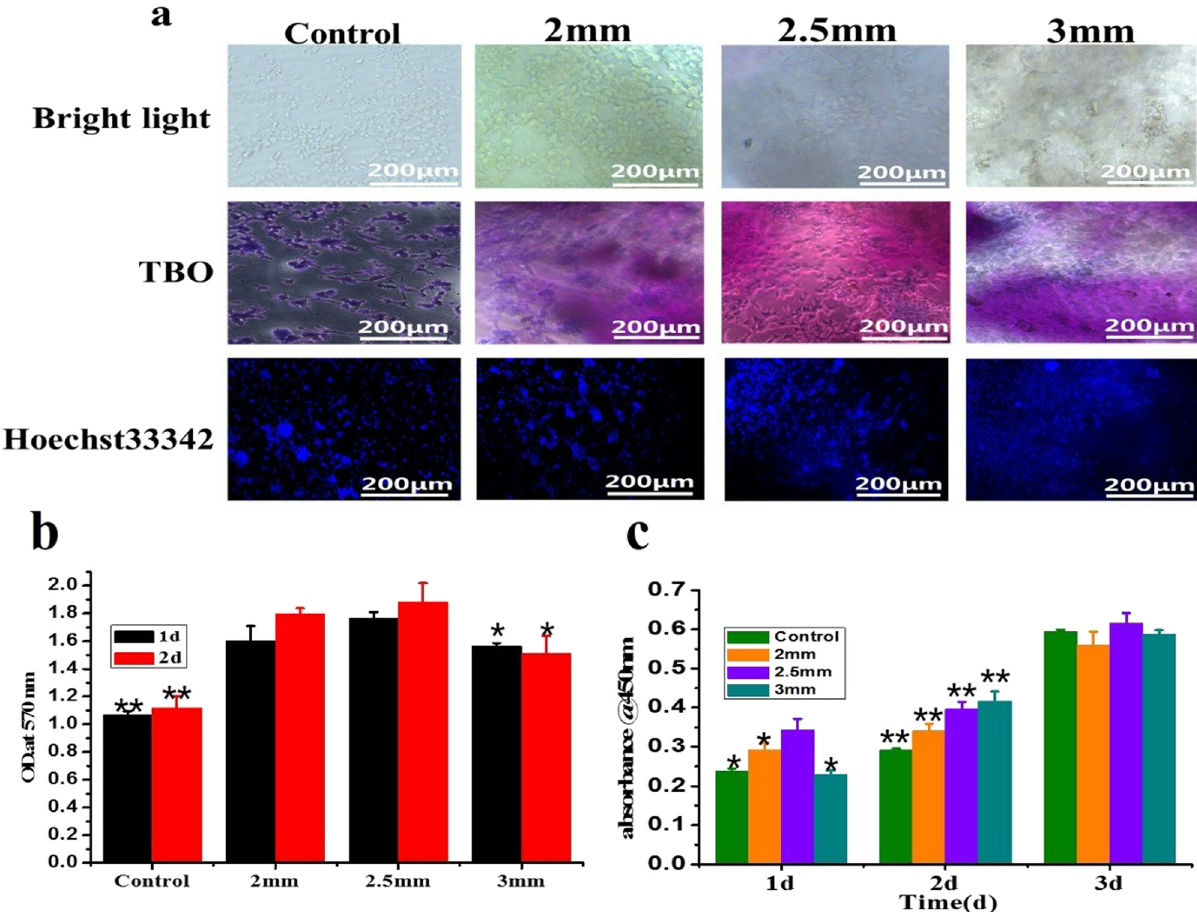
Figure 6: Cell morphology and toxicity of GG/ST sca ff olds. ( a ) TBO and immuno fl uorescence; ( b ) MTT test cytotoxicity experiment; ( c ) cell viability detection. * p < 0.05 and ** p < 0.01 by one - way ANOVA